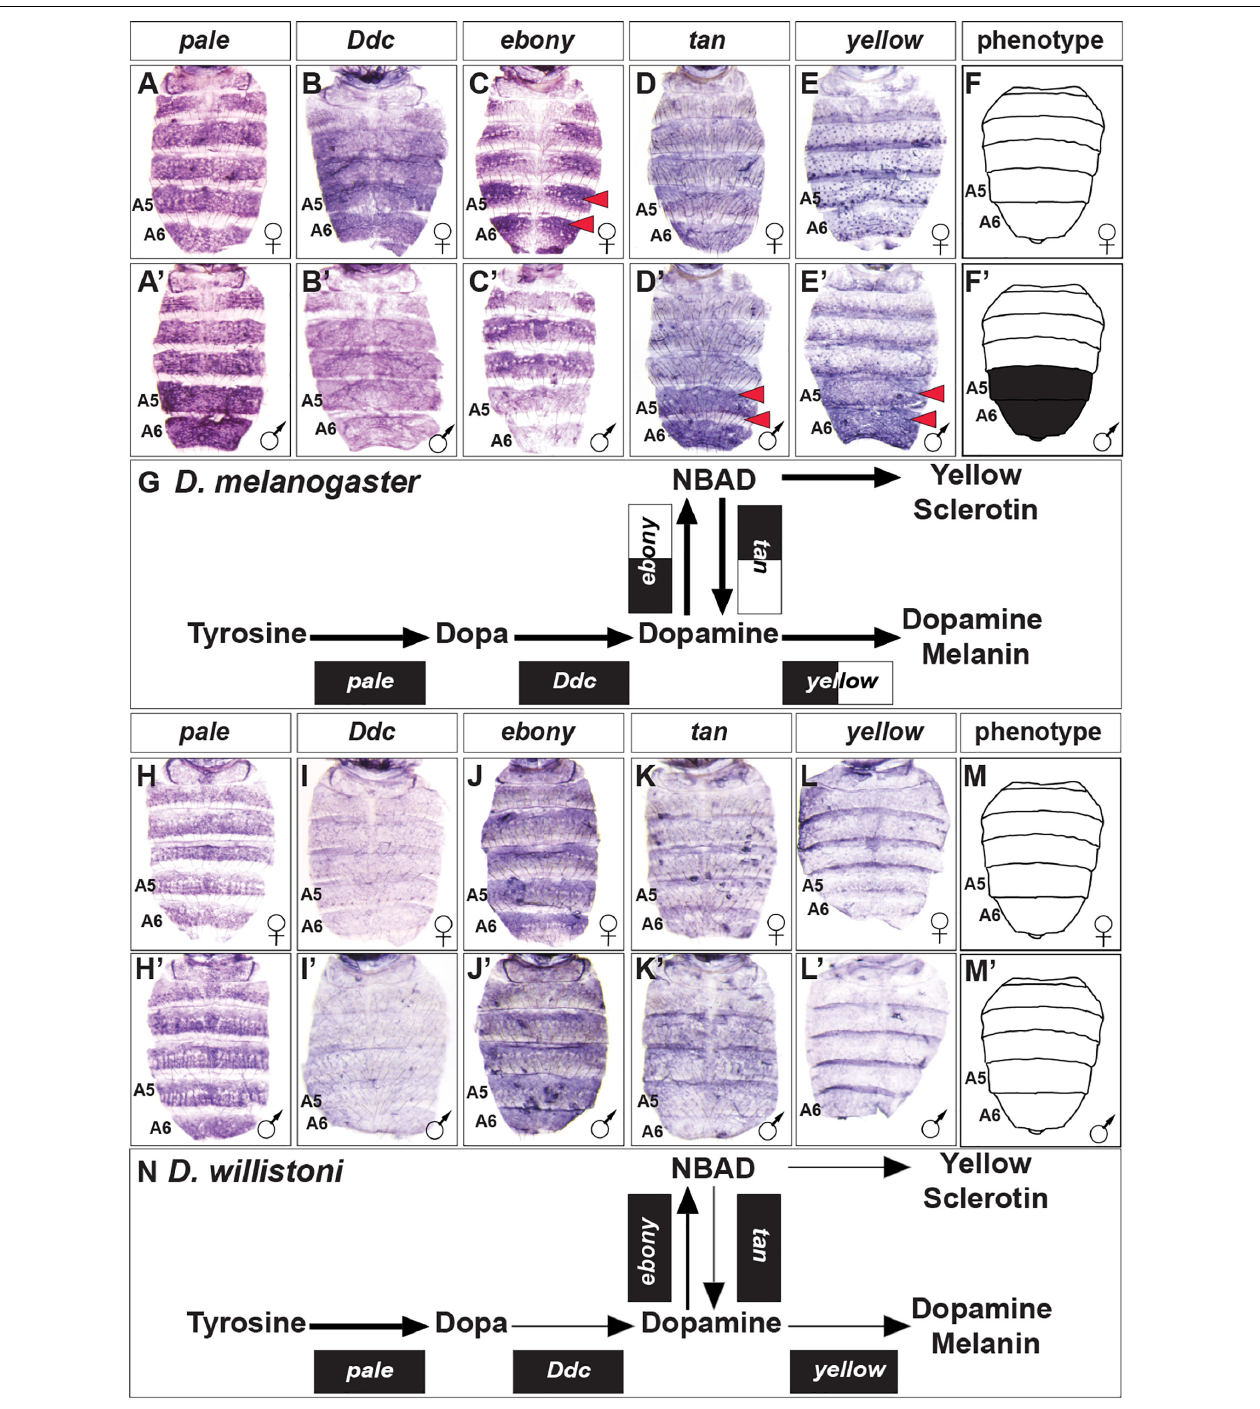
FIGURE 3 | Contrast in the pigment metabolic pathway utilization between the dimorphic D. melanogaster and the monomorphic D. willistoni . (A–E) Female and (A’–E’) male expressions of D. melanogaster pigment metabolic pathway genes, and (F,F’) cartoon representation of the pigmentation phenotype. (G) Summary of the D. melanogaster pathway use includes robust expression of all genes, with dimorphic expressions of ebony , tan , and yellow . (H–L) Female and (H’–L’) male expressions of D. willistoni pigment metabolic pathway genes, and (M,M’) cartoon of the pigmentation phenotype. (N) Summary of the D. willistoni pathway use includes modest and monomorphic expression of most genes. (A,A’,H,H’) pale , (B,B’,I,I’) Ddc , (C,C’,J,J’) ebony , (D,D’,K,K’) tan , and (E,E’,L,L’) yellow . Red arrowheads indicate robust patterns of dimorphic expression in the A5 and A6 segment epidermis. (G,N) Black arrow thickness represents the level of expression for the underlying gene. Monomorphic gene expression is represented by the gene names being placed upon a black rectangle. Dimorphic gene expression is represented by the gene names being placed upon a black and white colored rectangle.